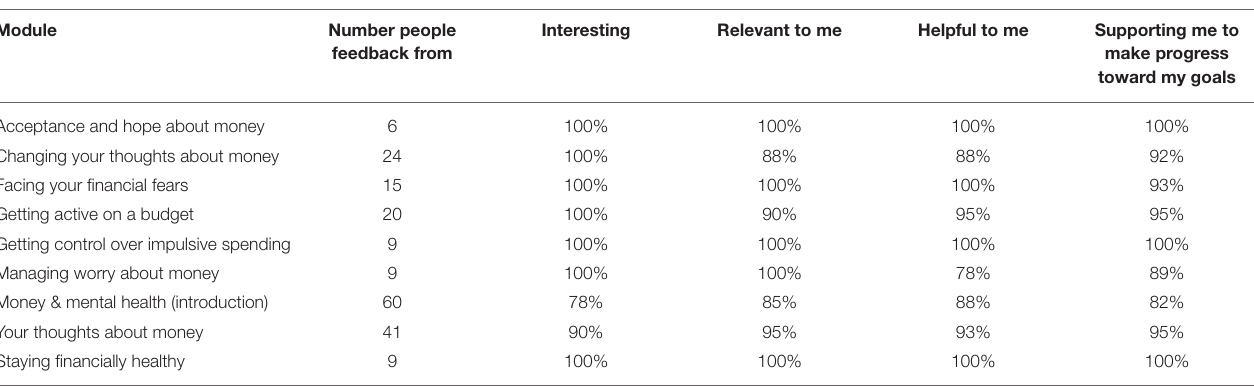
TABLE 4 | Feedback on the